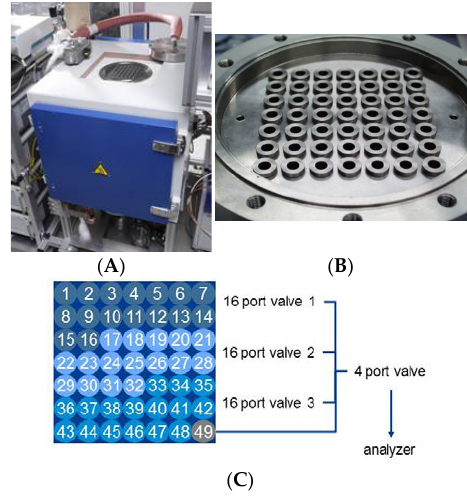
Figure 2. Reactor layout for HT testing unit ( A ). The reactor ( B ) (closeup view) has 48 equivalent positions for catalyst screening and one position (labelled as 49), which is used as a by-pass line to perform periodic measurements of the inlet concentrations. Numbering and relation of positions are shown in part ( C ).